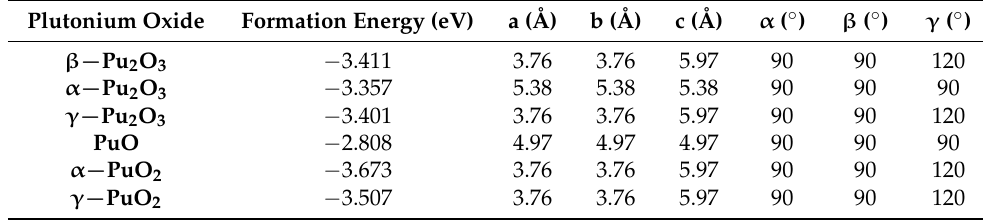
Table 1. Lattice parameters of β -Pu 2 O 3 , α -Pu 2 O 3 , γ -Pu 2 O 3 , PuO, α -PuO 2 , γ -PuO 2 , include formation energy, lattice constant and bond angle α , β , γ .